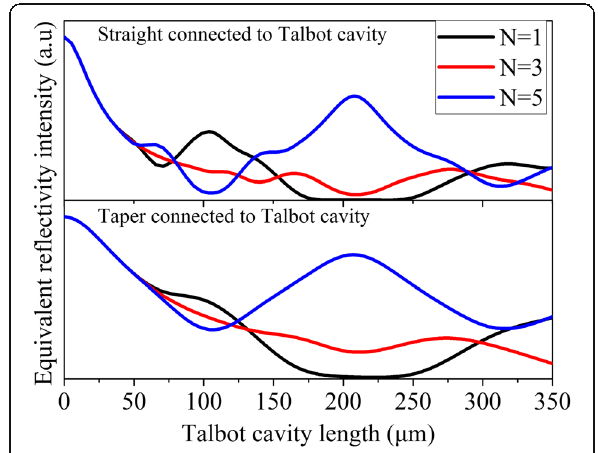
Fig. 4 Theoretical equivalent reflectivity intensity of the Talbot cavity changes as a function of the Talbot cavity length for N = 1, 3, 5 order supermodes of a five-element Talbot cavity QCL array, the upper shows the straight-end connected to the Talbot cavity and the lower shows the taper-end connected to Talbot